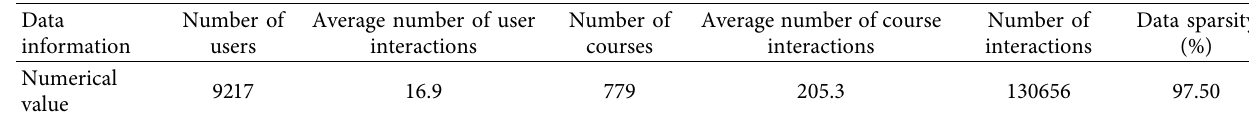
Figure 6: Knowledge graph ripple network propagation model diagram. (a) Dialogue entities. (b) Dialog entity level 1 associated entity. (c) Dialog entity level 2 associated entity. (d) Dialog entity level 3 associated entity. Table 1: Basic statistical information of the dataset.